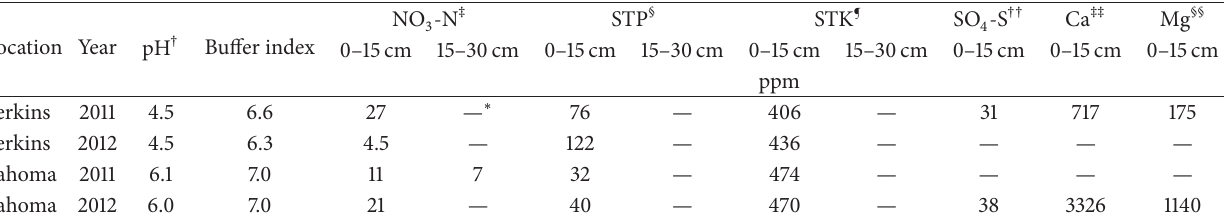
Table 1: Preplant composite soil sample results in Perkins and Lahoma, OK, in 2011 and 2012. Samples were collected in the summer, a month prior to planting.